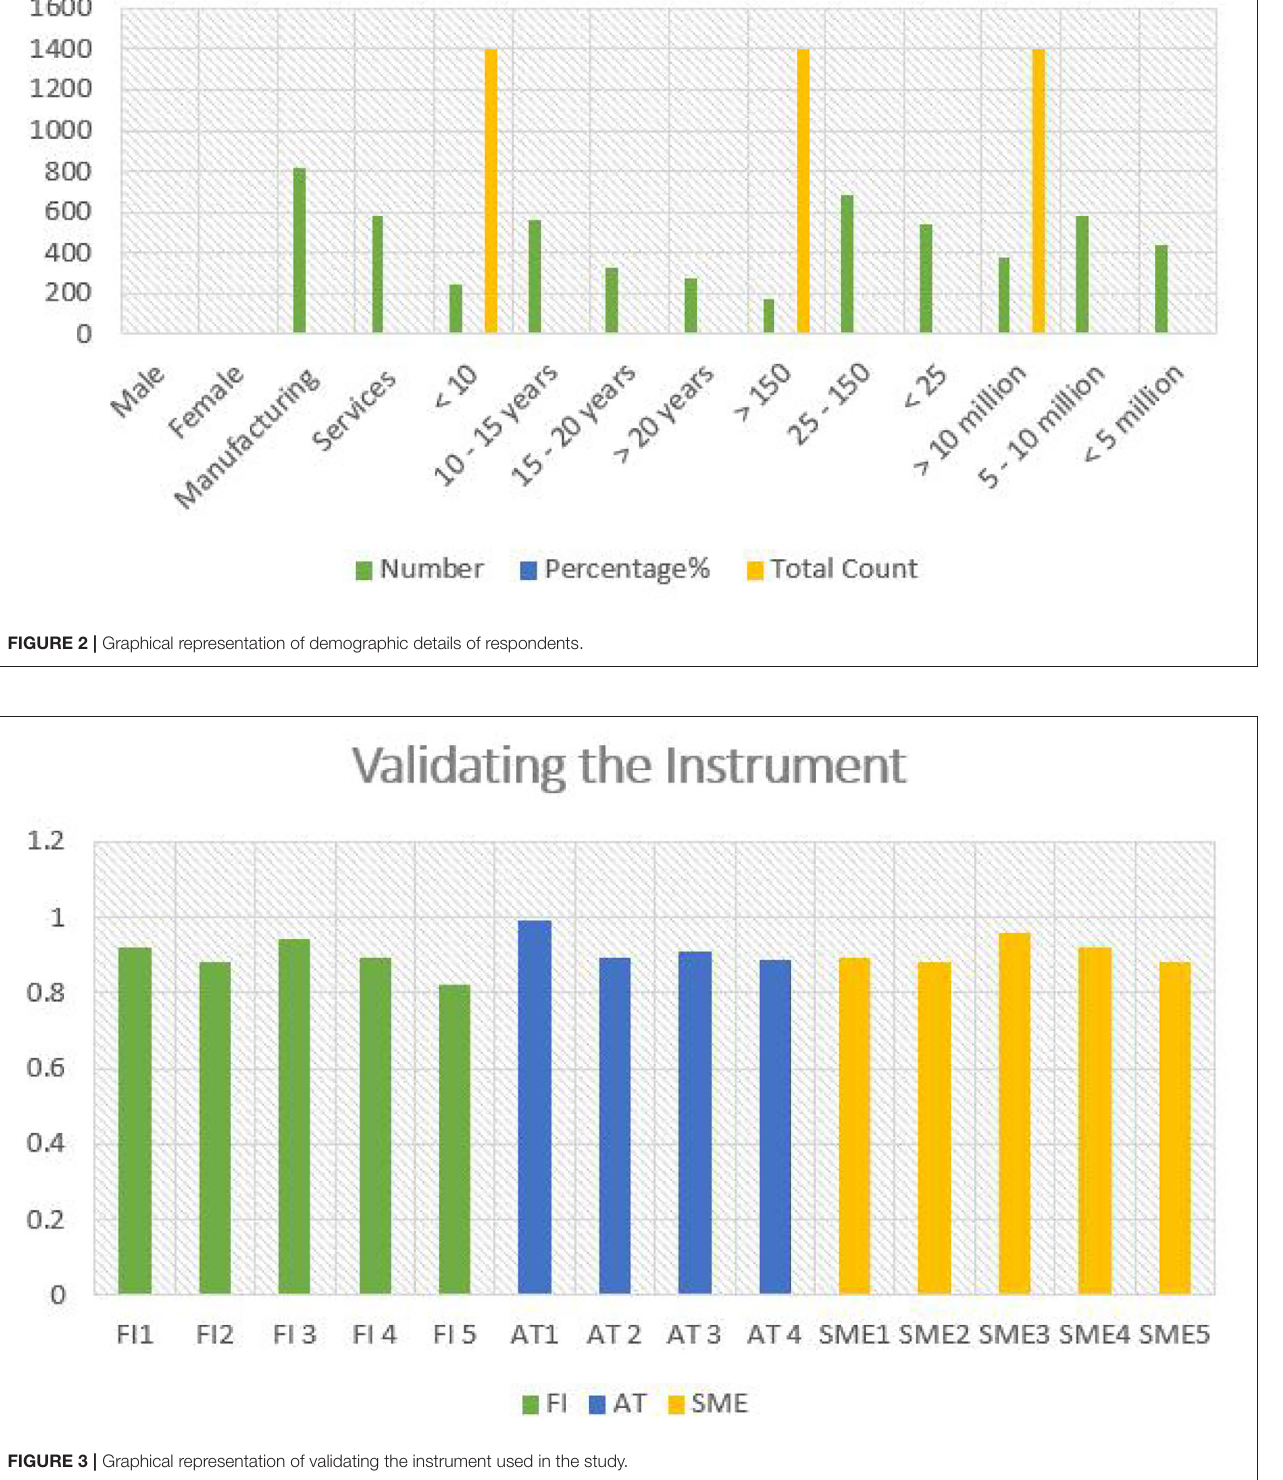
Frontiers in Public Health |